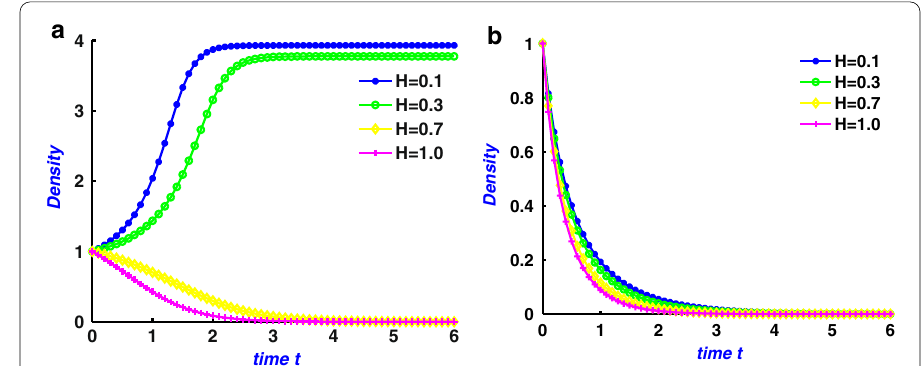
1.0 and r 4.0 , u 0 1.0 with various harvesting rate as = = = 0.6 (weak Allee effect), and b M 0.6 (strong Allee = = −